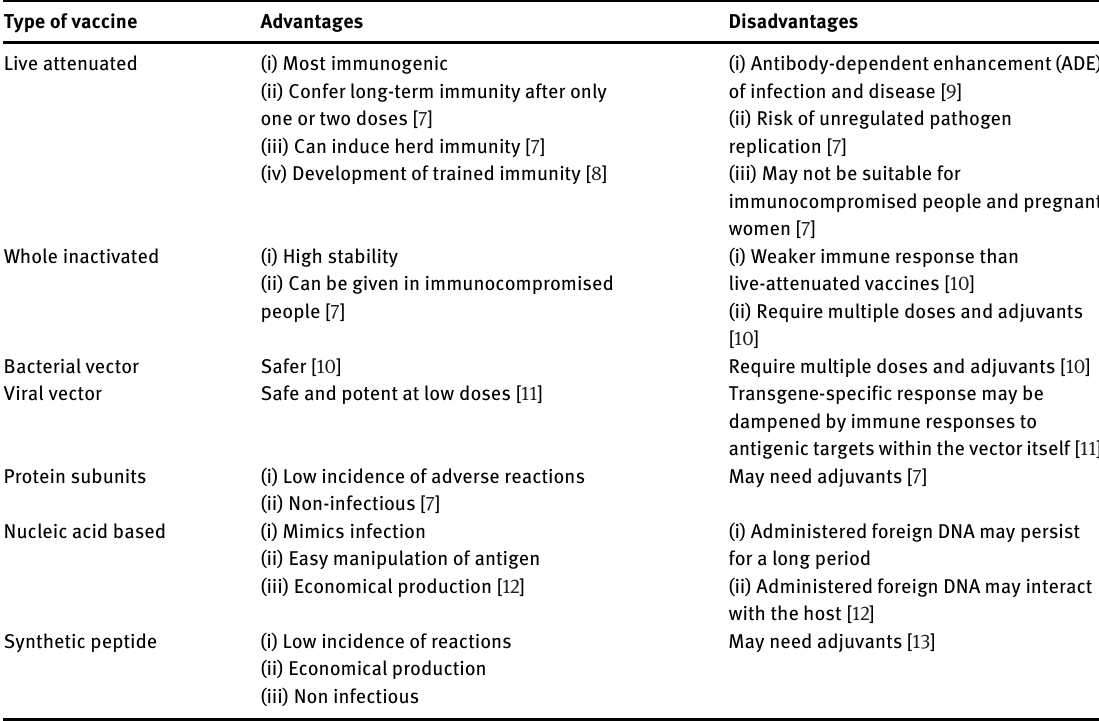
Table 1: Advantages and disadvantages of each vaccine strategy. Type of